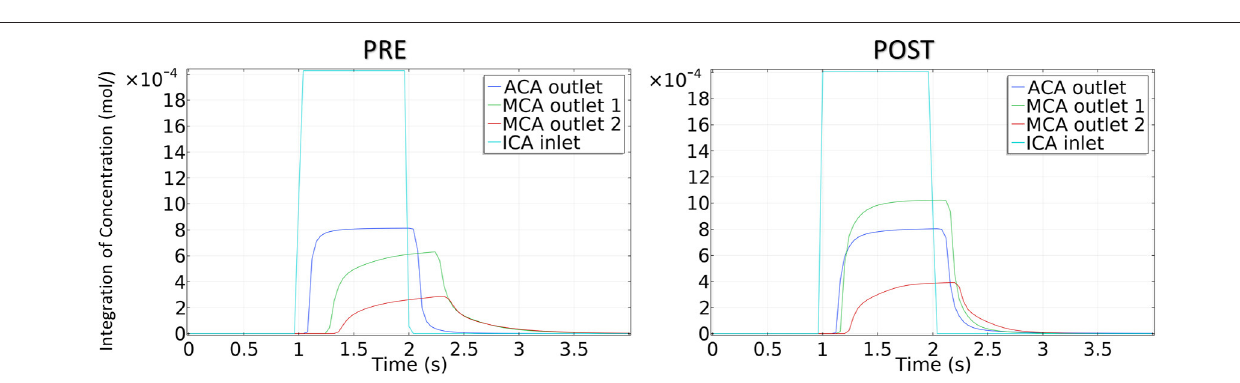
FIGURE 9 | The concentration of contrast material in the patient-derived model.